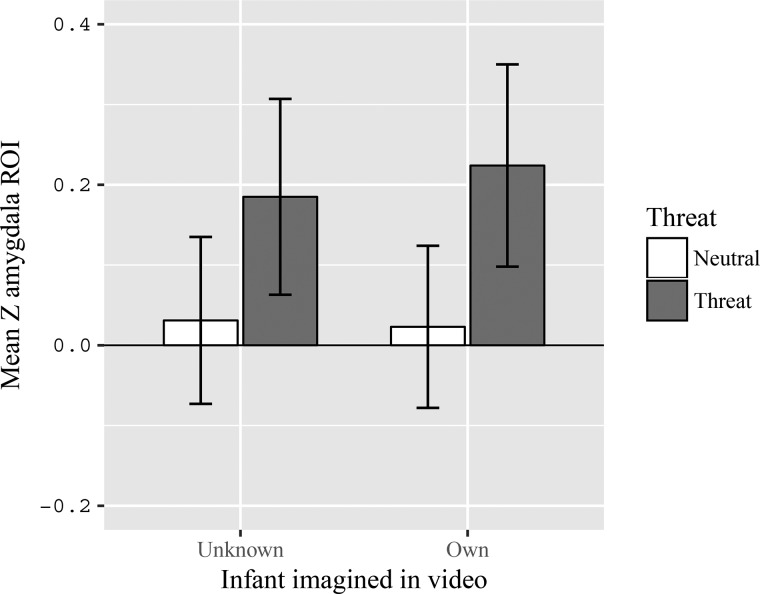
Amygdala activation as a function of threat (threat vs neutral) by familiarity (own vs unknown infant). Activation was higher for threatening situations compared to neutral situations. Error bars represent standard errors of the mean.